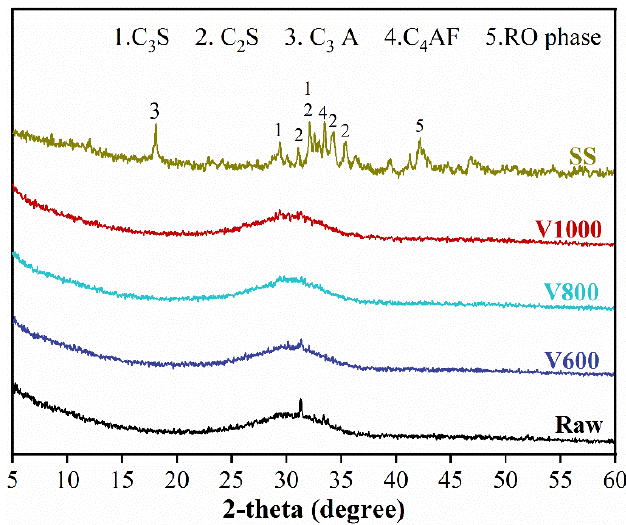
Figure 2. The XRD patterns of BFS and SS.